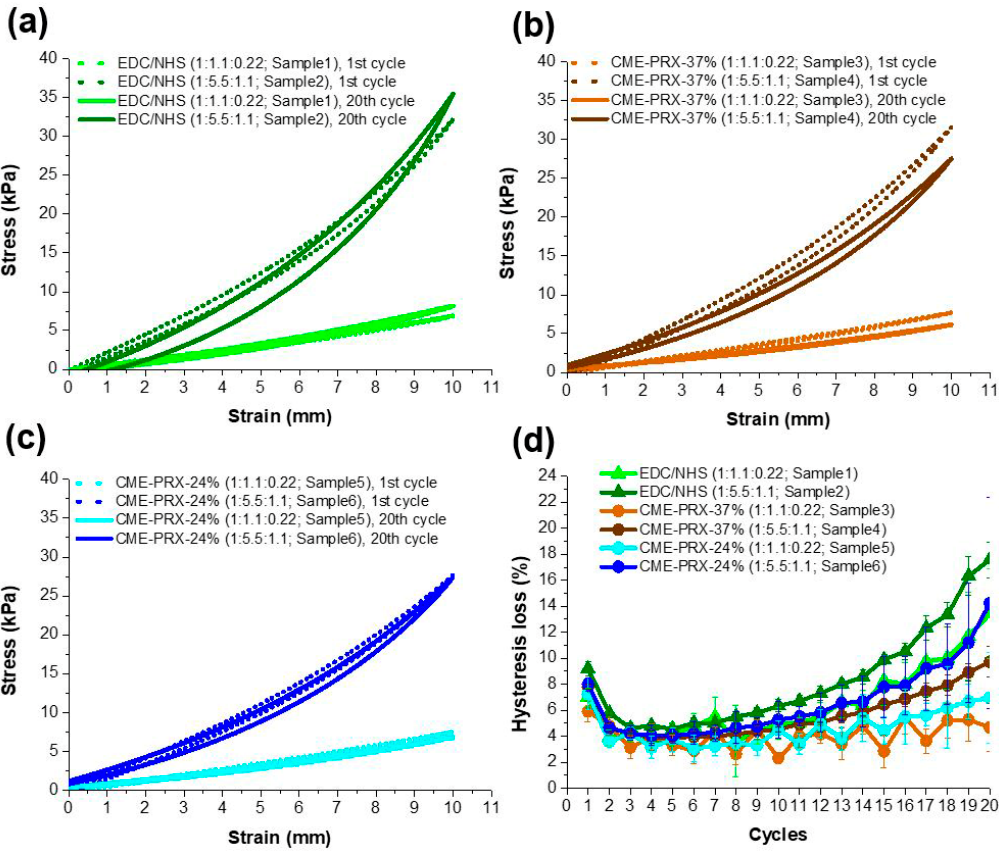
Figure 5. Cyclic tensile test for gelatin hydrogels cross-linked by ( a ) EDC/NHS; ( b ) CME-PRX-37%; ( c ) CME-PRX-24%; ( d ) Hysteresis loss of gelatin hydrogels in each cycle (n = 3).